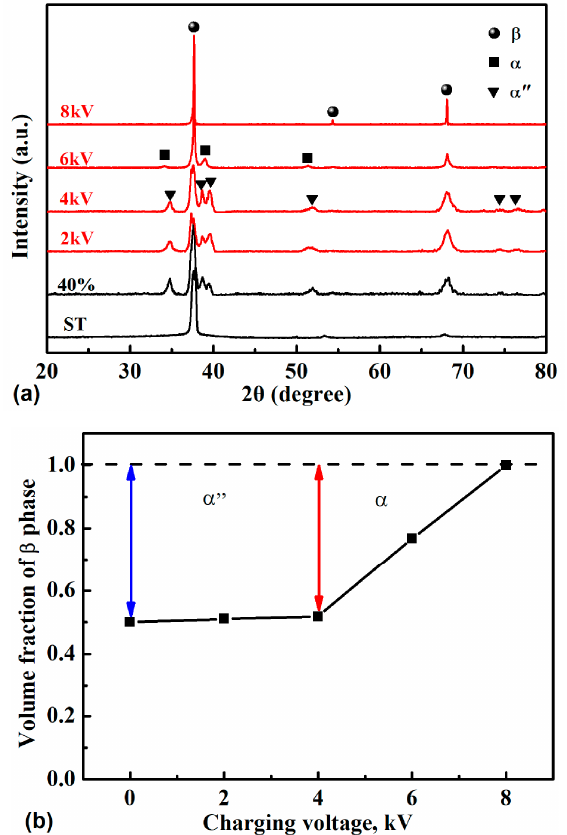
Figure 3. XRD patterns of the solution-treated (ST) specimen, cold-rolled specimen, and electropulsing-treated specimens ( a ) and variation of the volume fraction of the β phase at increasing charging voltage ( b ).